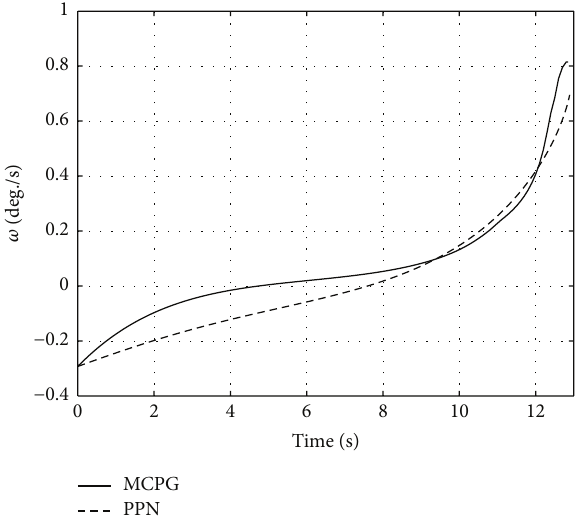
Figure 7: Longitudinal acceleration.